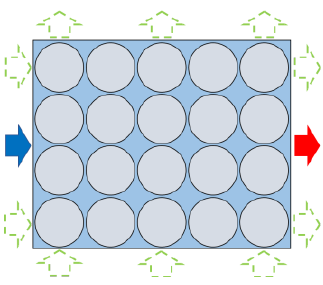
Figure 10. Optional choices of inlets and outlets.